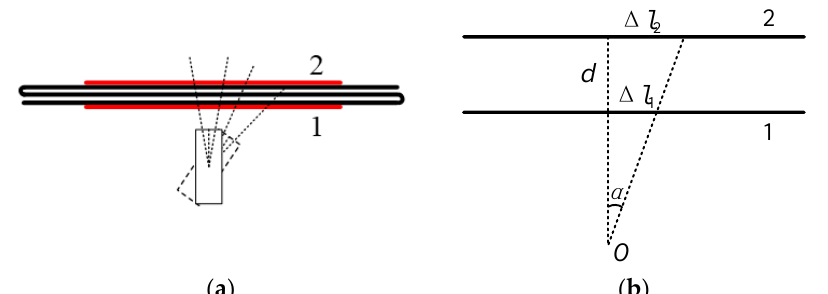
Figure 7. Schematic diagram of the airflow deflection and the corresponding geometric relationship of the deflection angle: ( a ) Diagram of the deflection angle measurement; ( b ) Geometric relationship of the deflection angle.